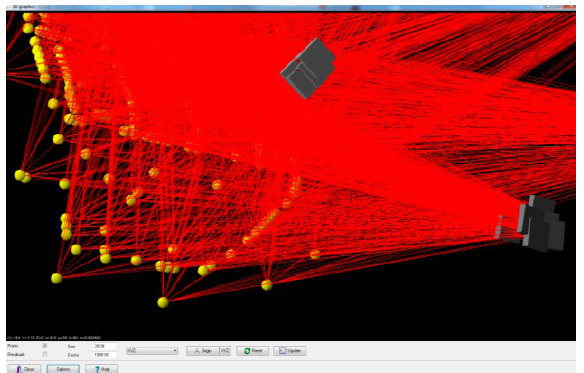
Figure 13: Interactive 3D viewer